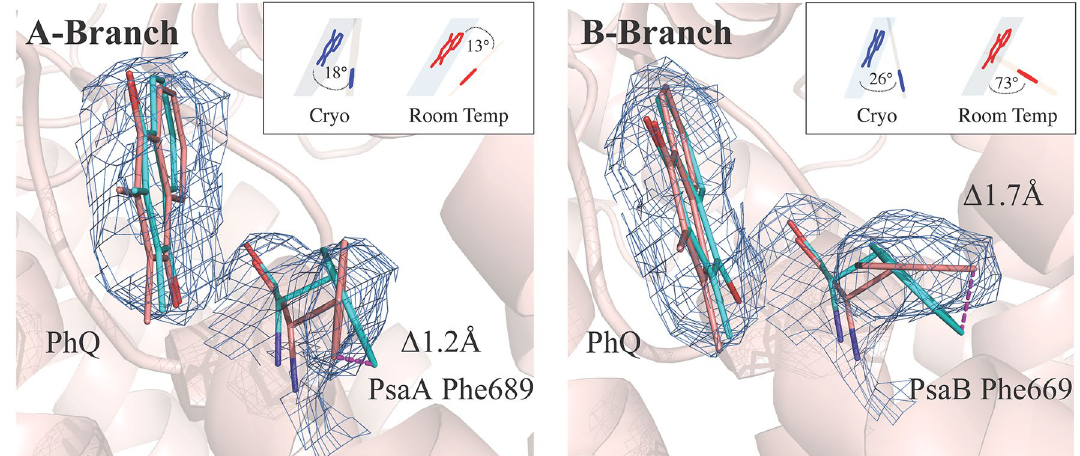
Figure 4. 2F obs − F calc electron density contoured to 1.5 σ with the modeled phylloquinone in the PsaA and PsaB electron transport pathways. For aromatic residues PsaA-Trp697 and PsaA-Phe689 of PsaA and PsaB- Trp677 and PsaB-Phe669 of PsaB (salmon) the orientation obtained from the cryogenic structure (1JB0) is overlaid in cyan. PsaA-Phe689 is twisted relative to the cryogenic structure to a more parallel orientation with the phylloquinone. The B site reveals PsaB-Phe669 in an orientation more perpendicular to the plane of the phylloquinone. The stick representation of the PsaB-Phe669 and PsaA-Phe689 aromatic ring plane angles to phylloquinone in room temperature structure versus 1JB0 is shown in the inset. Both sites reveal significant shifts of atomic coordinates. Figure generated with Pymol v. 2.4.0a0. https:// pymol.